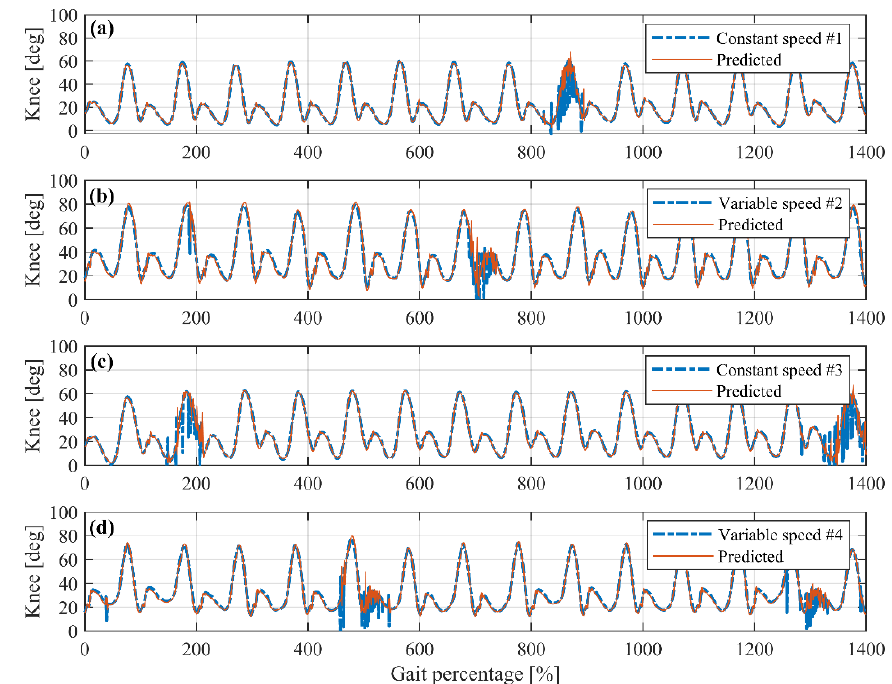
Figure 16. Reliability analysis of BP neural network continuous prediction.